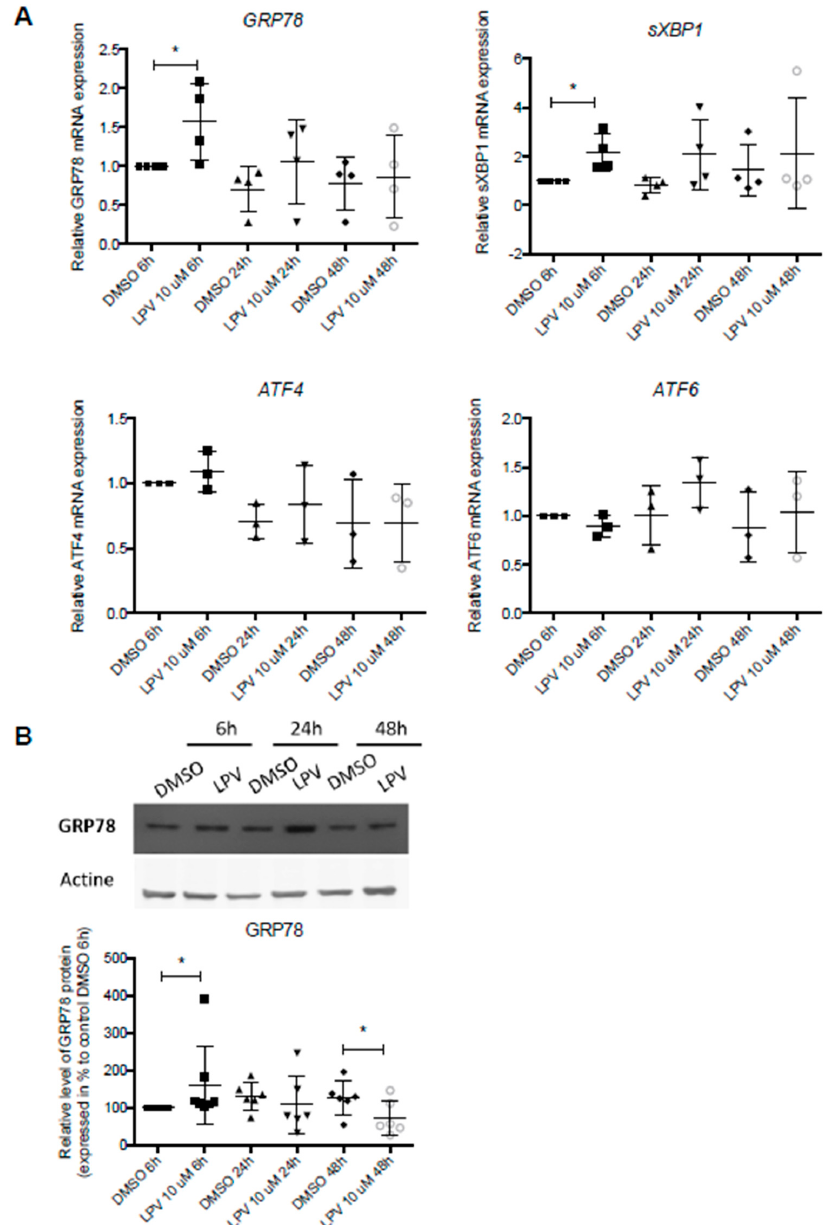
Figure 8. LPV induces activation of IRE1 α pathway from 6 h of incubation in trophoblasts cells. VCT cells were isolated from human term placenta. After 15 h of culture, cells were incubated for 6 h, 24 h or 48 h with 10 µ M LPV. ( A ) Transcriptional expression of GRP78 , sXBP1 , AFT4 and AFT6 were measured by RT-qPCR. ( B ) Protein expression of GRP78 was evaluated by immunoblotting with anti-GRP78 antibody. Actin protein expression determined with anti-actin antibody was used as loading control. The results are expressed as mean +/ − SD of n = 4 independent experiments. * p < 0.05 vs. DMSO at the same incubation time, two-tailed paired no parametric t